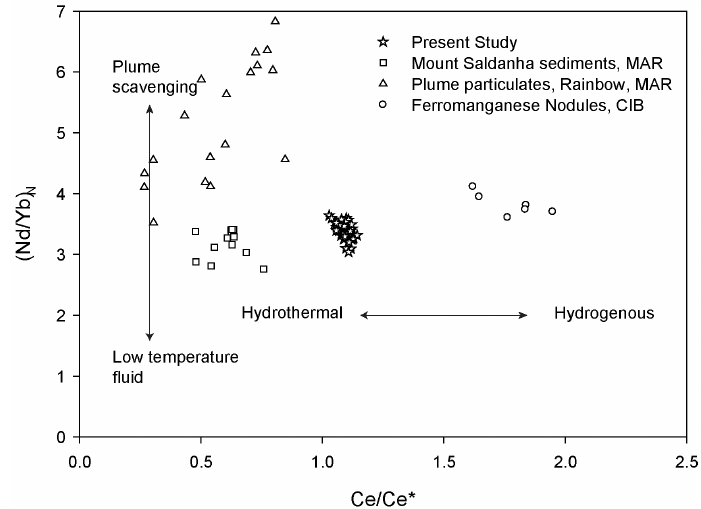
Figure 11. Plot of Ndn/Ybn against Ce/Ce* for the BC-10 core comparison with other studies. Data points are taken from different sources, Mount Saldhana sediments from Mid Atlantic Ridge [64], Plume particulates from Rainbow Hydrothermal Field [65], and ferromanganese nodules from Central Indian Basin [66].